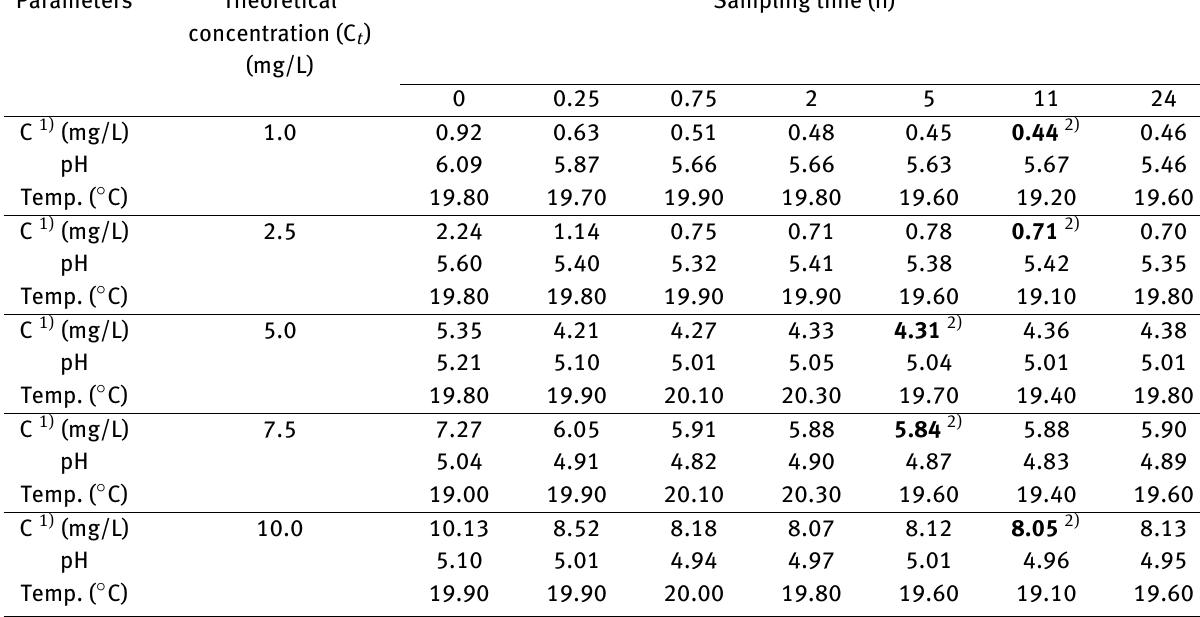
Table 2: Results for experiments with Cu